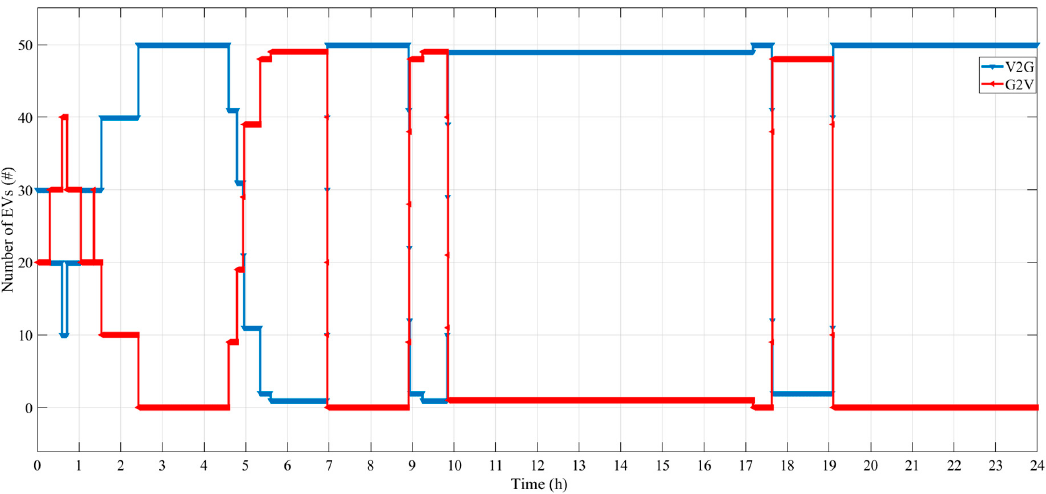
Figure 10. Number of EVs for each phase that can countersuit to V2G and G2V for scenario A. Energies 2019 , 12 , x FOR PEER REVIEW